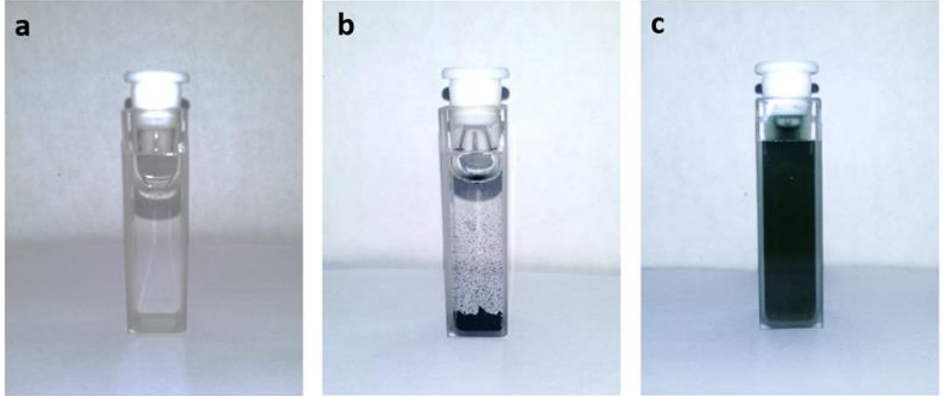
Figure 1. Schematic representation of the PNIPAM- b -PANI synthesis. PNIPAM = Poly( N - isopropylacrylamide); PANI = polyaniline; ATF = aminothiophenol; ANI = aniline; APS = ammonium peroxydisulfate.